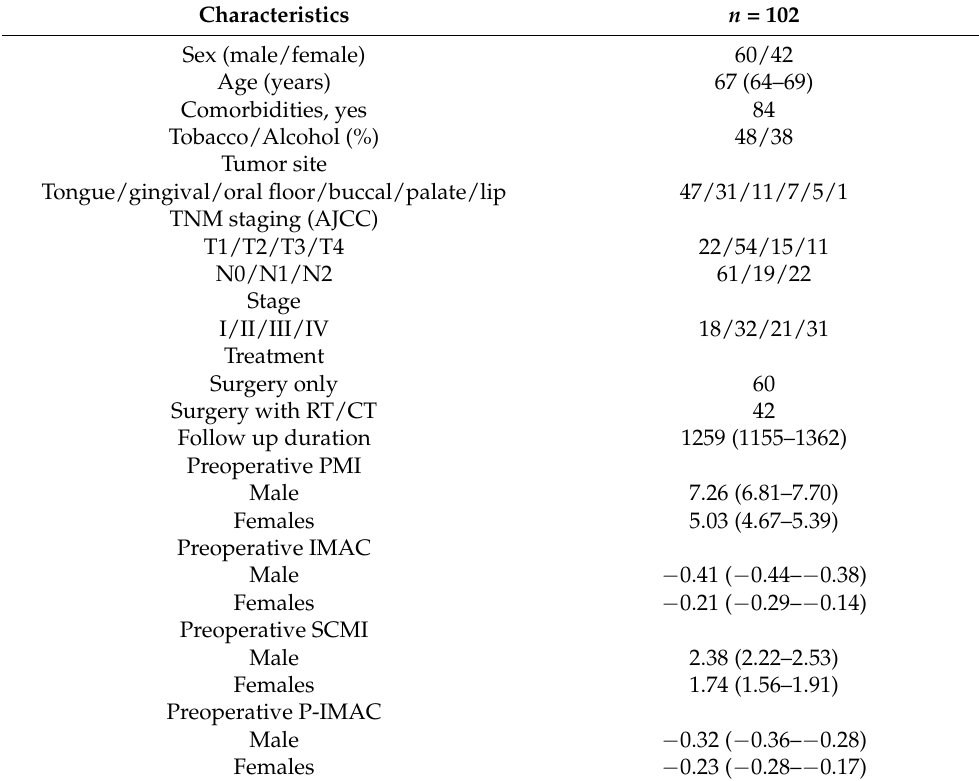
Table 1. Patient characteristics.